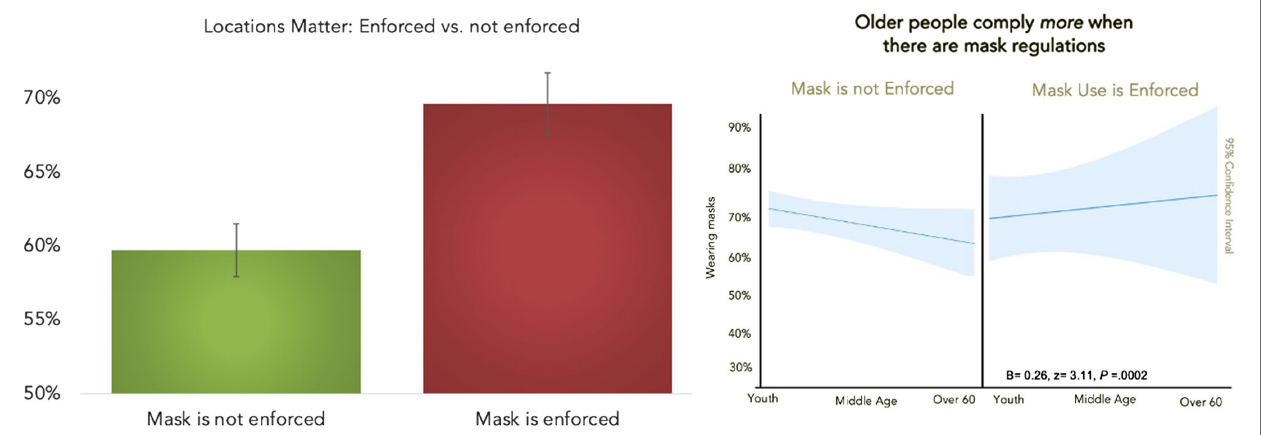
FIGURE 3 | 64.9% wore masks during the day compared to 59.2% at night (left) . 65.3% of people wore masks in the city center compared to 59.6 of in suburbs (right)